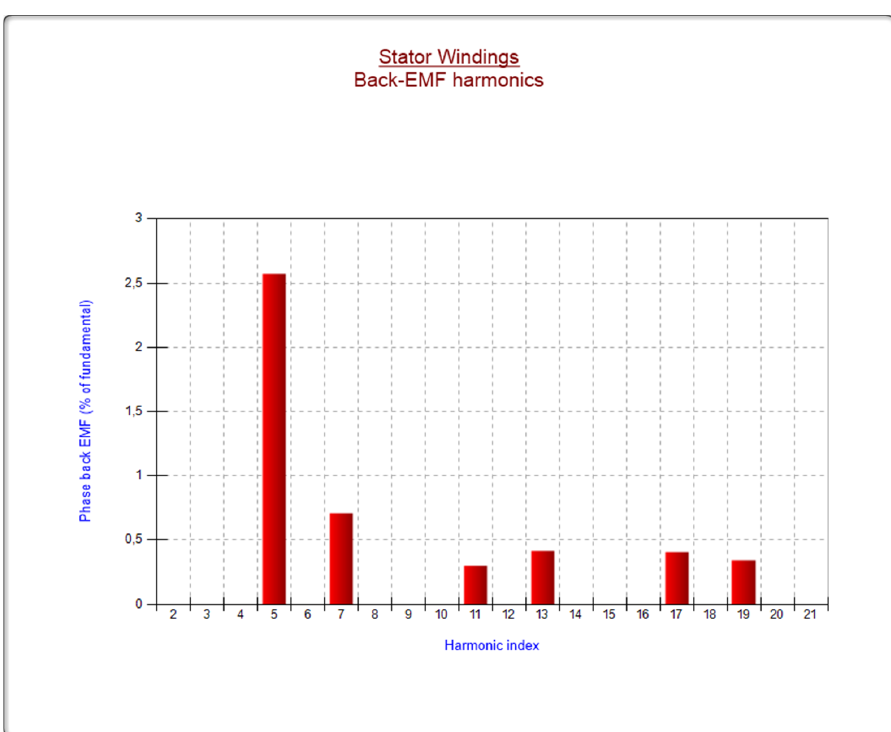
Figure 21. Analysis of EMF harmonics content.